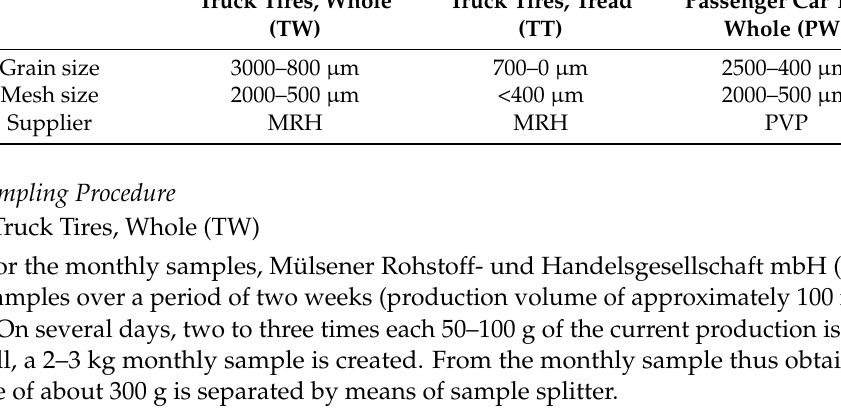
Truck Tires, Whole Truck Tires, Tread Passenger Car Tires, (TW) (TT) Whole